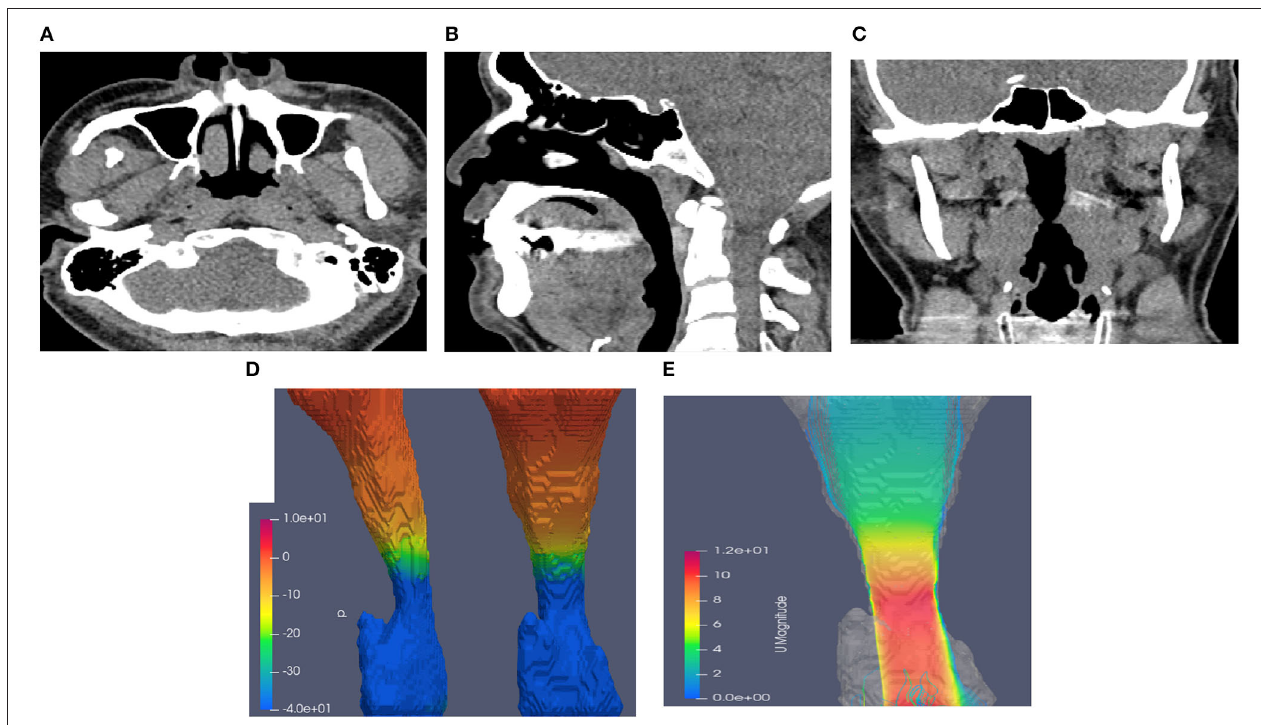
FIGURE 3 | Neck CT with computational fluid dynamics study of the 44-year-old male showed CTL34. (A) Axial view. (B) Sagittal view. (C) Coronal view. (D) Airway pressure of 51.88Pa. (E) Airflow velocity of 10.7 m/s.